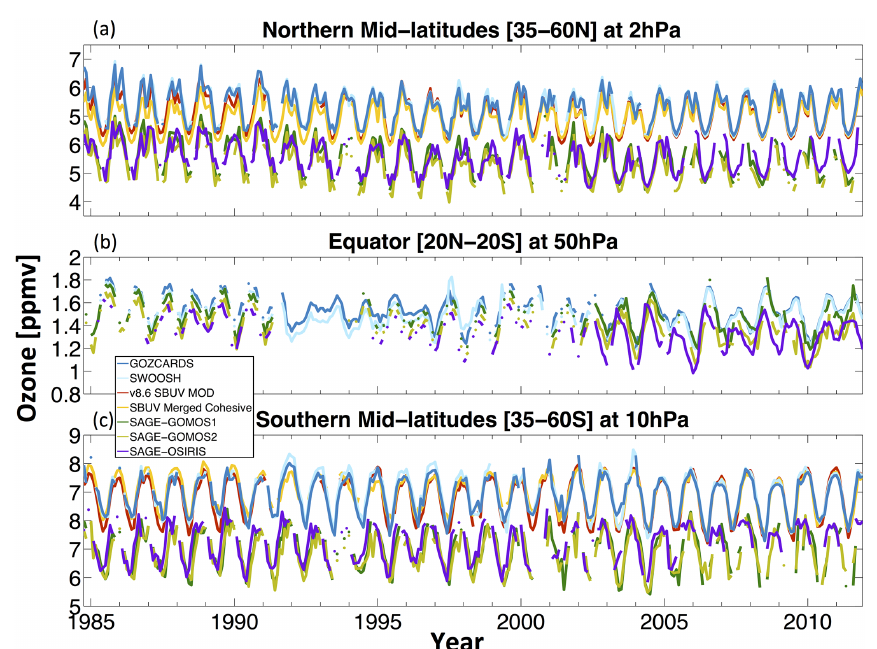
Figure 4. Monthly mean ozone (ppmv) in (a) the Northern Hemisphere mid-latitudes (35–60 ◦ N) at 2hPa, (b) the tropics (20 ◦ N–20 ◦ S) at 50hPa, and (c) the Southern Hemisphere mid-latitudes (35–60 ◦ S) at 10hPa. Note that the data sets are separated in the two mid-latitude plots (a) and (c) for clarity, and thus the y -axis values are